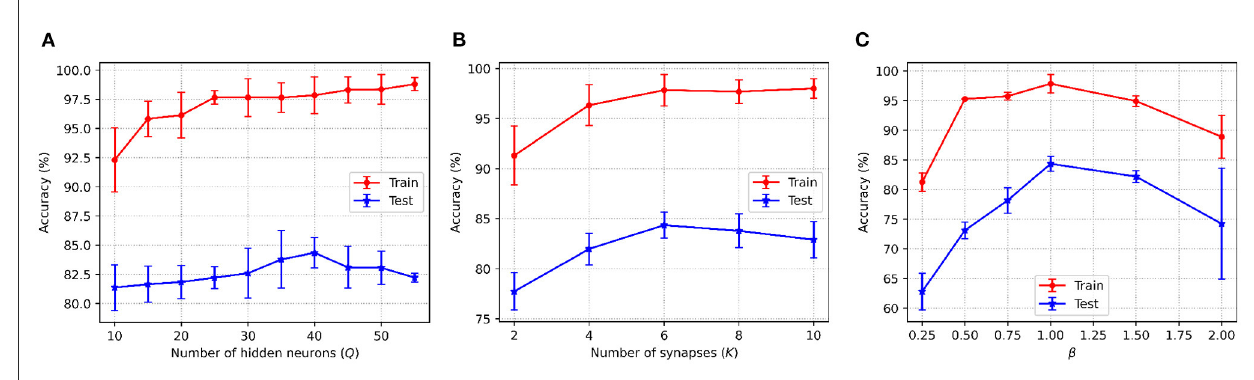
FIGURE4 C-STNet accuracy changes with the different values of (A) : The number of hidden neurons, (B) : The number of synapses, and (C) : The constant β in the coding